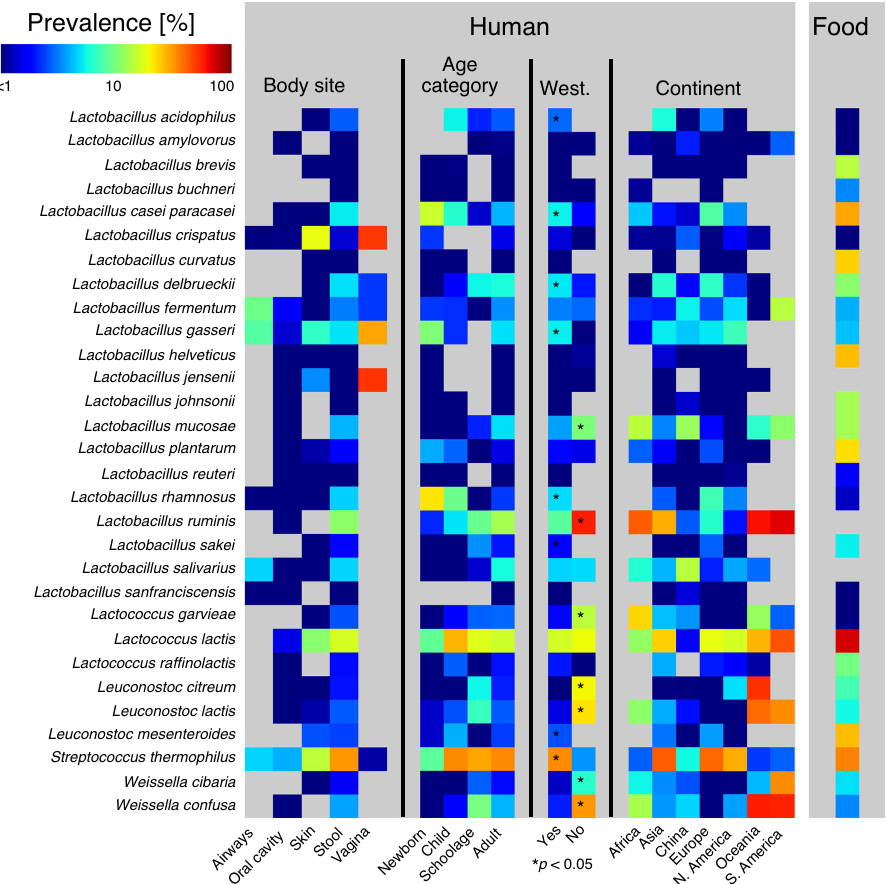
Fig. 1 Average prevalence of LAB species from human and food microbiomes. We report the 30 LAB species having a prevalence >0.1% in the human gut. Values are obtained from 9445 publicly available human metagenomes and strati fi ed by multiple host conditions (i.e., body site, age category, westernized lifestyle, and continent). Age category, westernized lifestyle, and continent statistics refer to stool samples only. Food results are obtained from 303 food metagenomes. Numbers and p -values (Fisher ’ s test, false discovery rate correction) in Supplementary Figs. 1 – 4 and Supplementary Data 4. Relative abundances in Supplementary Data 2 and